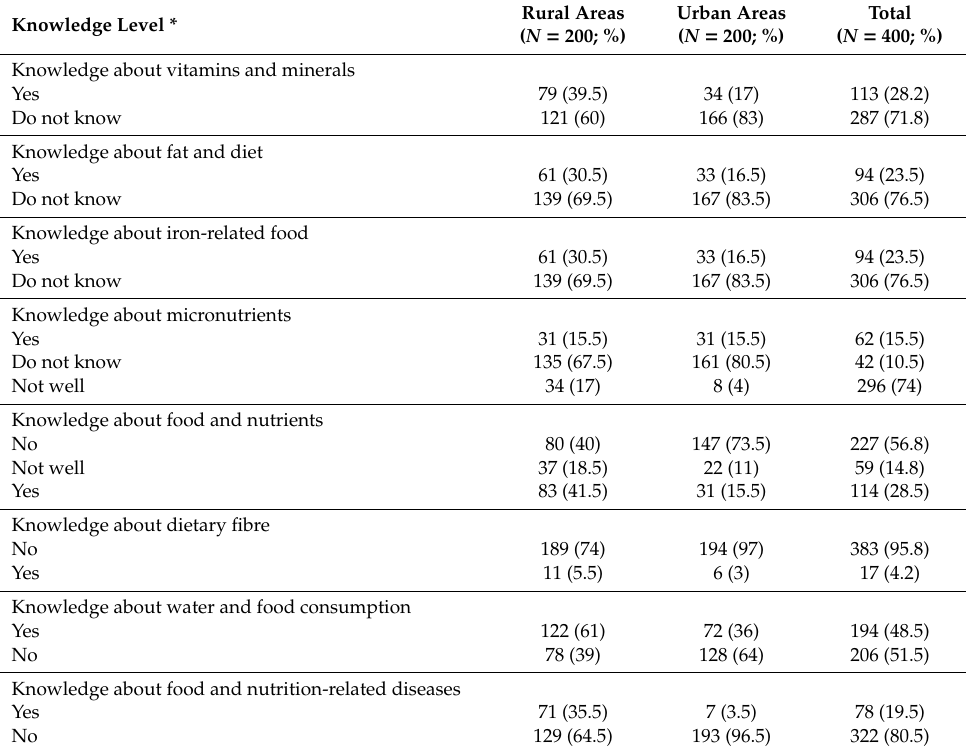
Table 4. Knowledge level of reproductive-age women in urban and rural areas in Sri Lanka regarding nutrition ( N = 400).